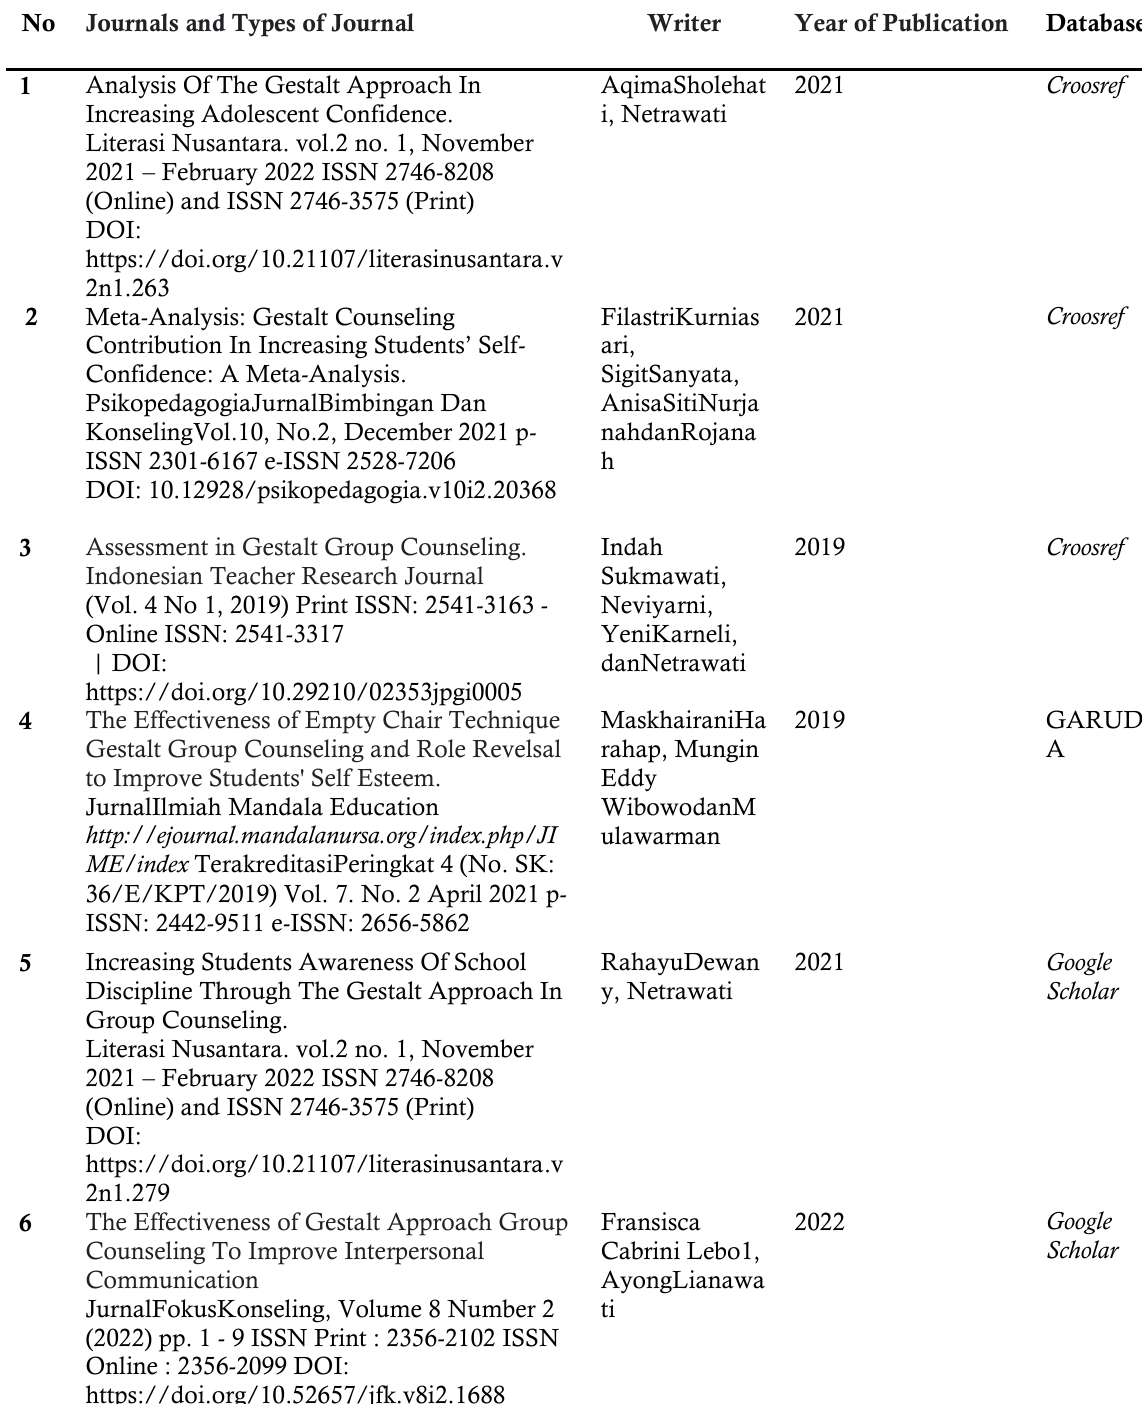
Table 2< Journals and Types of